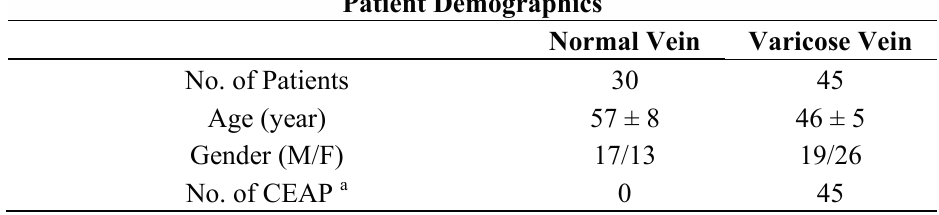
Table 2. Information of patients in different